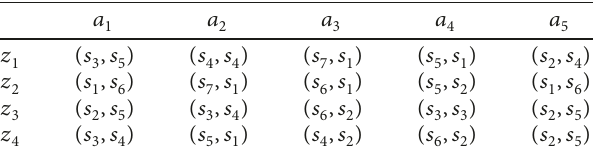
Table 16: Normalized decision matrix R